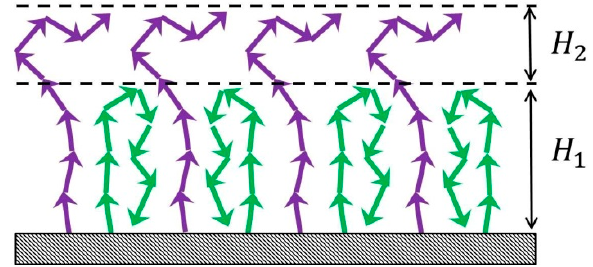
Figure 7. Schematic representation of the planar brush with two populations of chains (backfolded— green arrows and extended—violet arrows).